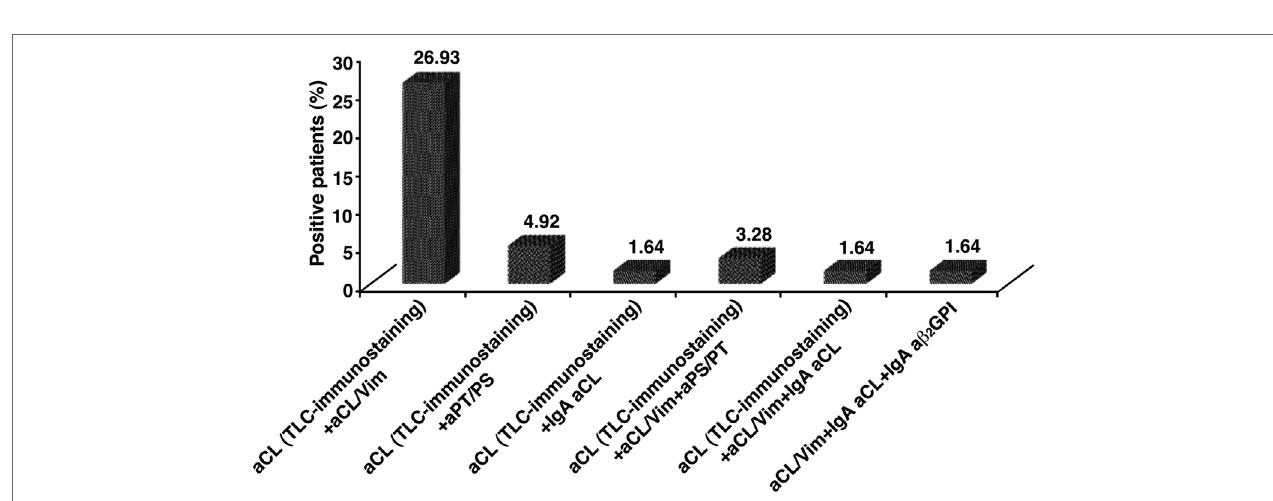
FigUre 2 | The percentage of obstetrical seronegative anti-phospholipid syndrome patients positive for more than one test used to detect the presence of autoantibodies. The combination of thin-layer chromatography (TLC)-immunostaining and anti-cardiolipin/vimentin (aCL/Vim) approaches detected autoantibodies in the majority of the patients.